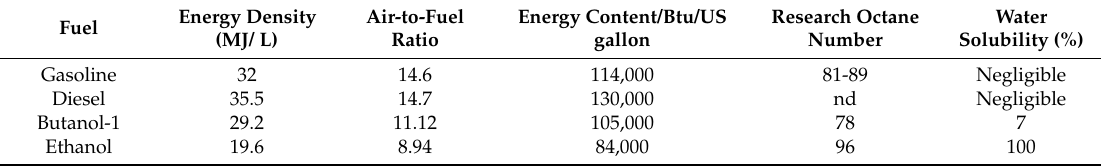
Table 1. Chemical and physical properties of gasoline, diesel, butanol and ethanol [35]. Energy Density Fuel (MJ/